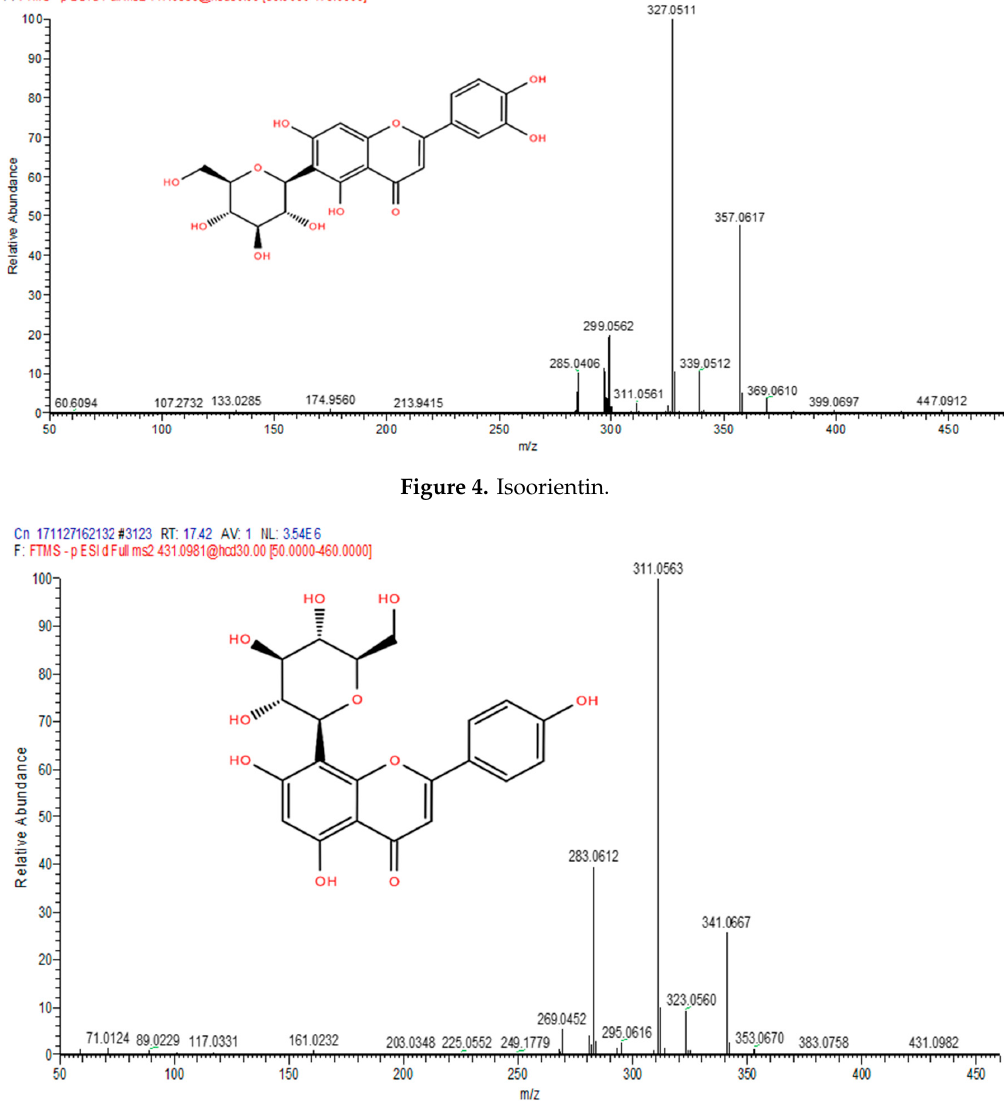
Figure 5. Vitexin.